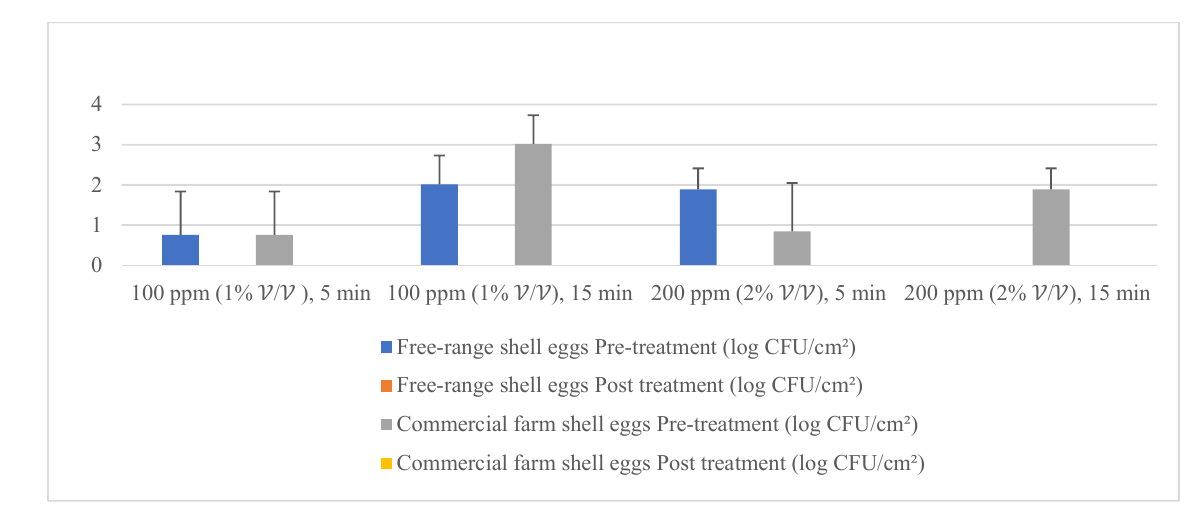
Figure 6. Mean population of molds (pre- and post-treatment) for free-range shell eggs and commercial farm shell eggs.